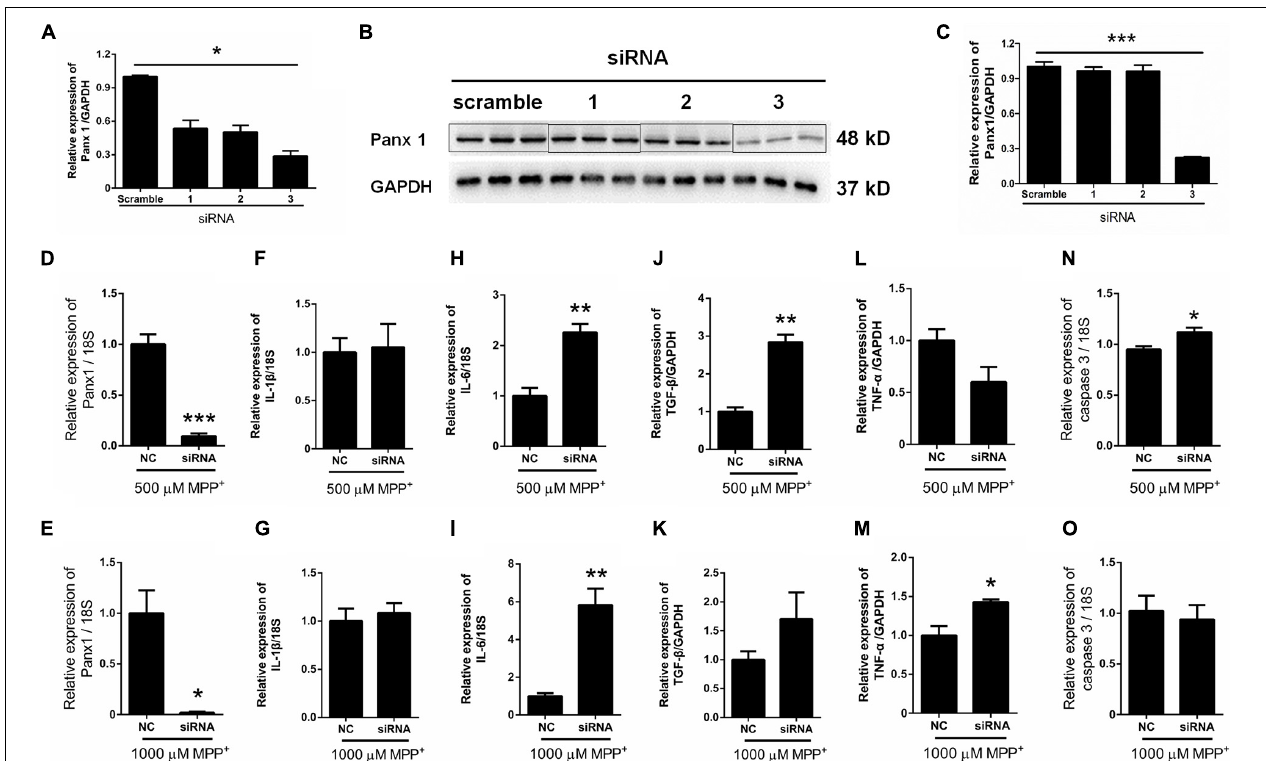
FIGURE 3 | Effect of Panx 1 downregulation on MPP + -induced apoptosis in primary cultured astrocytes. (A–C) The silencing efficiency of three Panx 1-targeting siRNA was determined by qPCR and western blot analysis in primary cultured astrocytes. (D,E) qPCR analysis of Panx 1 expression in negative control and siRNA groups treated with 500 or 1,000 µ M MPP + . (F–M) Effect of Panx 1 downregulation on the expression of selected inflammatory cytokines, including IL-1 β , IL-6, TNF- α , and TGF- β in MPP + -induced astrocytes. (N,O) Influence of Panx 1 siRNA on caspase 3 expression in MPP + - induced astrocytes. The data were normalized to GAPDH or 18S mRNA levels, n = 3. All data are mean ± SEM. Statistical comparison for (A,C) were performed using one-way ANOVA, following by Newman–Keuls Multiple Comparison Test, and for (D–O) using Student’s t -test. * p < 0.05, ** p < 0.01, *** p < 0.001 compared with negative